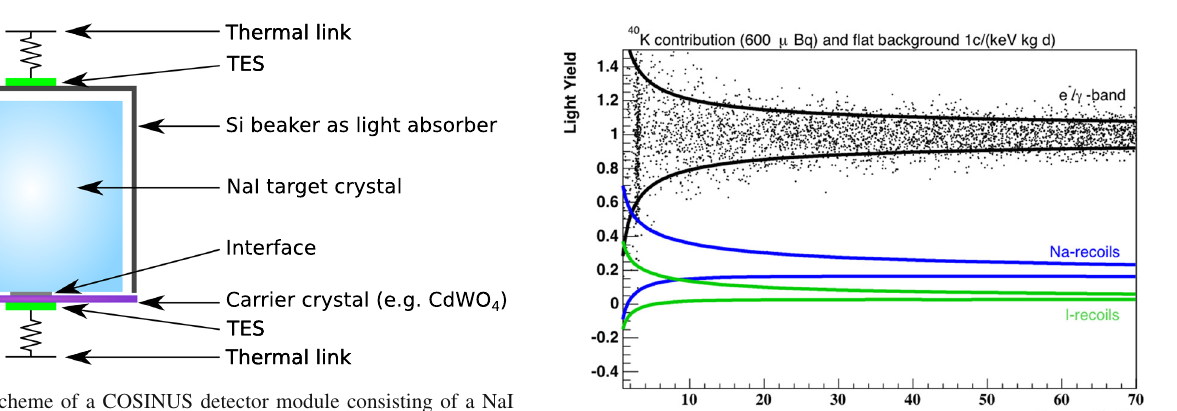
Fig. 1 Scheme of a COSINUS detector module consisting of a NaI targetcrystalcoupledtoacarriercrystal(phonondetector)andabeaker- shaped light detector. Both channels are read out via a Transition Edge Sensor (TES)